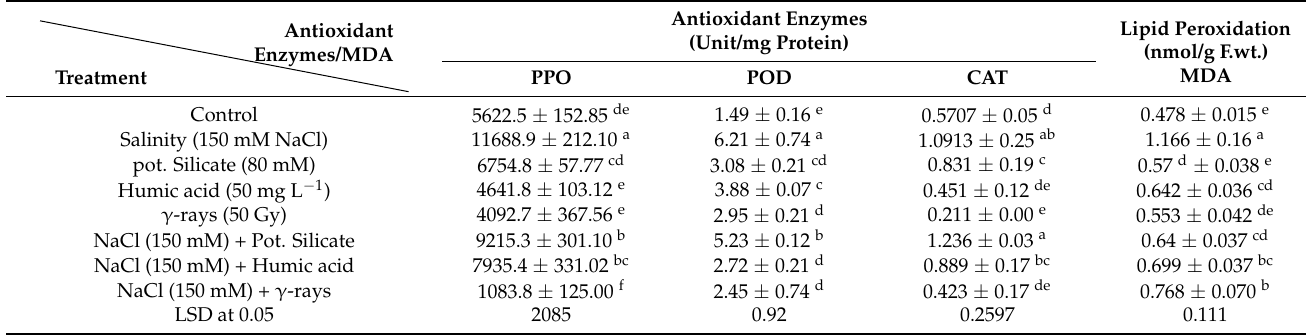
Table 8. Influence of biostimulants’ pretreatments on antioxidant enzymes PPO, POD, CAT (unit mg − 1 protein), and MDA (nmol g − 1 F. wt.) at flowering stage of coriander plants under salinity stress. Control and salinized stressed coriander samples were subjected to 80 mM pot. silicate, 50 mg L − 1 HA or soaked in water after exposure by 50 Gy γ -rays. Based on Duncan’s multiple range test, the different alphabetical letters express significant variation (defined as p <